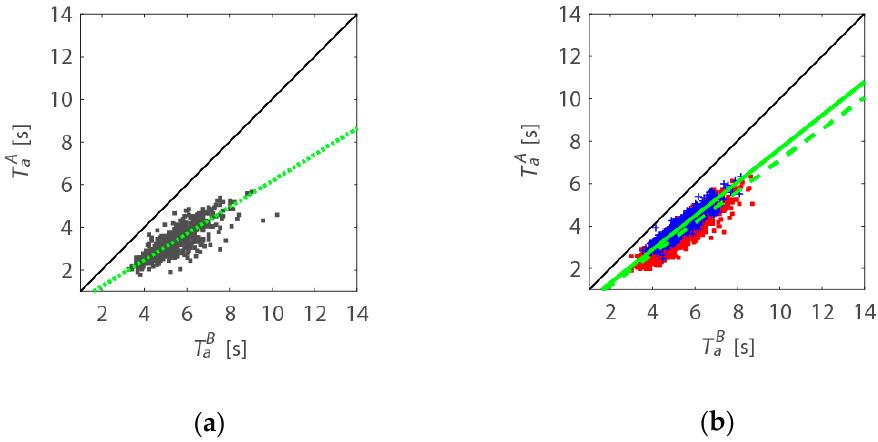
Figure 3. Buoy T B a and altimeter T A a when the wind speed is lower ( a ) or higher ( b ) than 5 m · s − 1 . In the right-hand panel, the blue (red) plots indicate data for which the wind speed is higher (lower) than 10 m · s − 1 . The regression lines estimated by the ODR method are plotted by the dashed (0–5 m · s − 1 ), broken (5–10 m · s − 1 ), and solid (>10 m · s − 1 ) green lines.